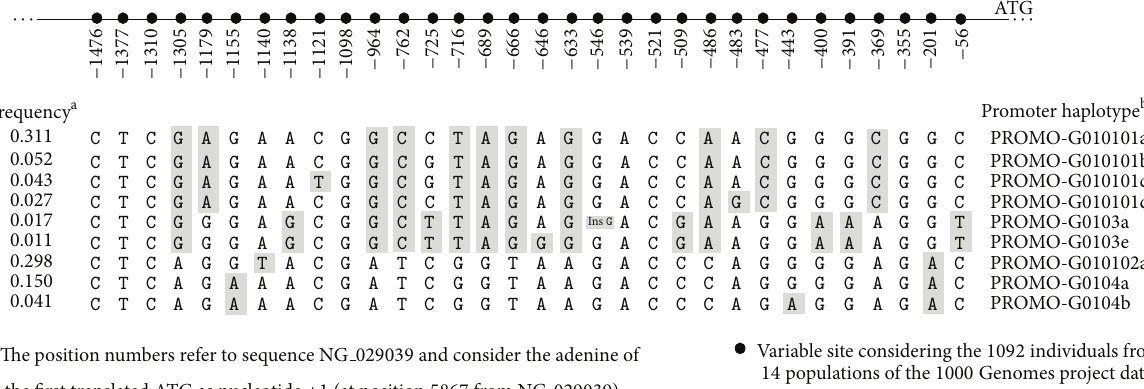
among the populations evaluated by the 1000